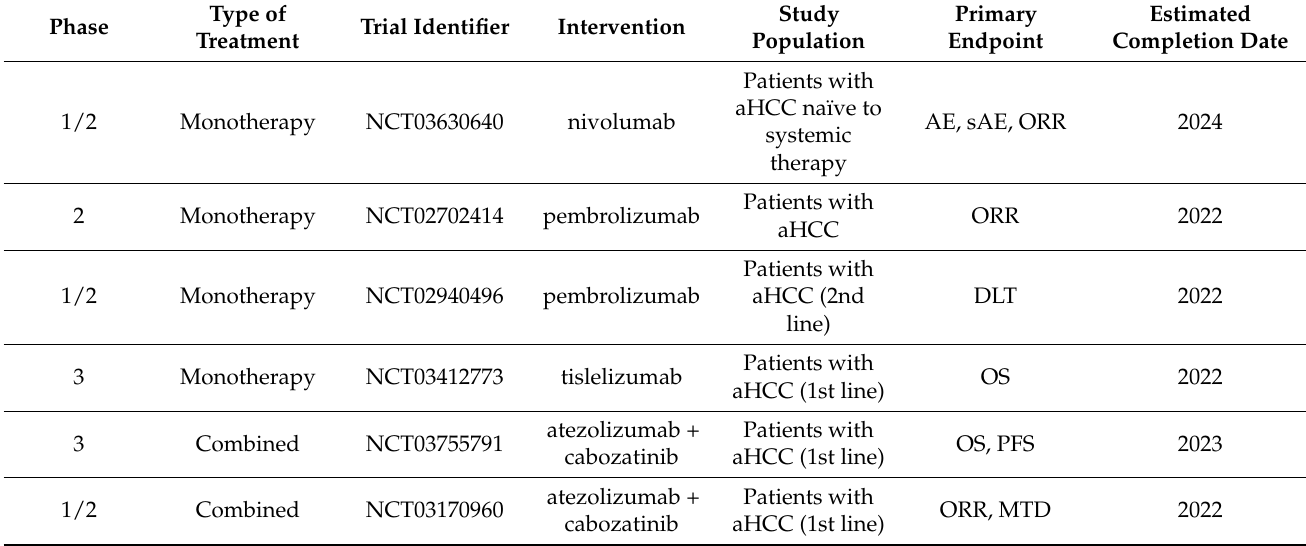
Table 2. Ongoing clinical trials assessing outcomes of patients with advanced HCC (aHCC) treated with immune checkpoint inhibitor mono- or combined